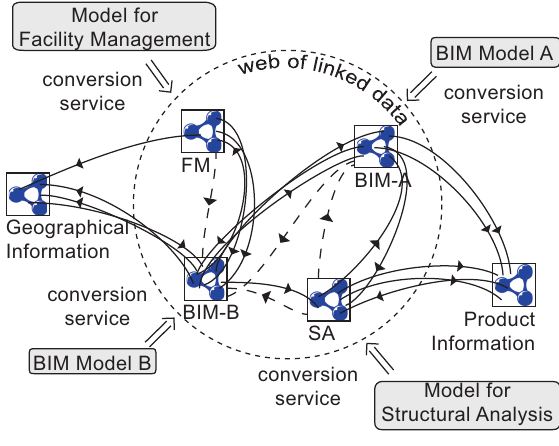
Figure 13. The linked data cloud for the AEC project can be further enriched with additional links to external resources of information (geographical information, product information, and so